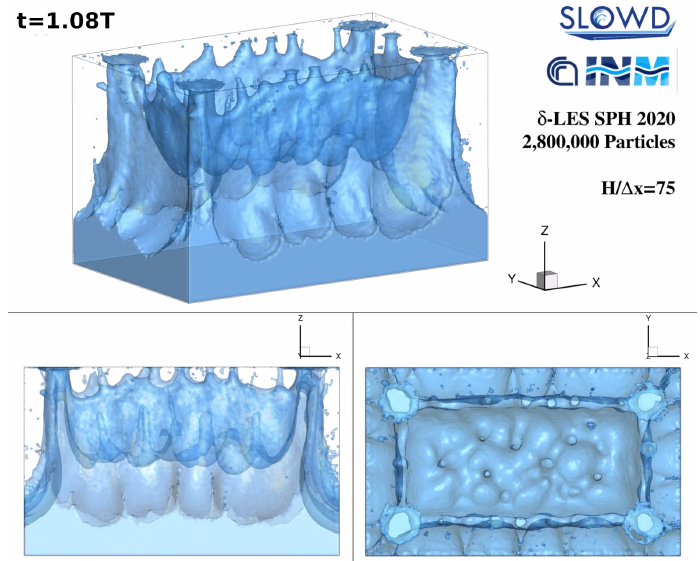
Figure 13. Test with water: free-surface at the first roof impact. Three-dimensional simulation. ( Top ) Three-dimensional view, ( Bottom ) lateral and from above views.